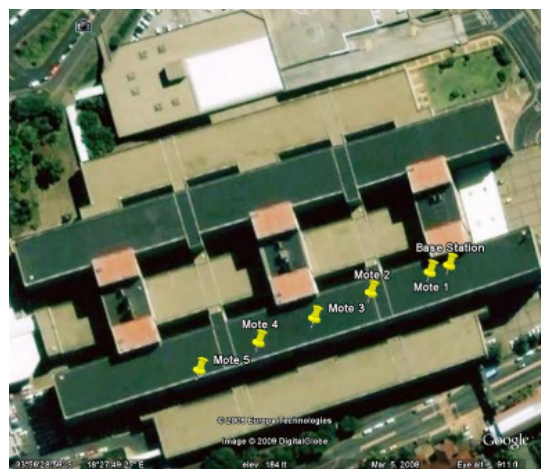
Figure 4. The Outdoor Testbed.